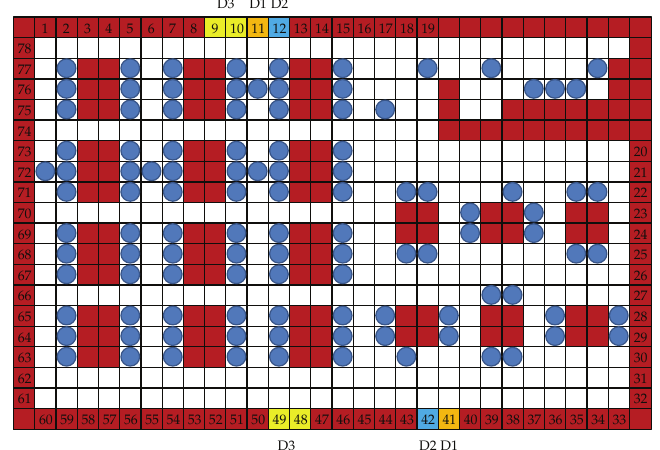
Figure 19: The restaurant from Figure 12 having two single-door and two double-door exits, with the best locations for the pair of doors labeled as D1 and D2 (cid:2) two single doors (cid:3) and D3 (cid:2) two double doors (cid:3)